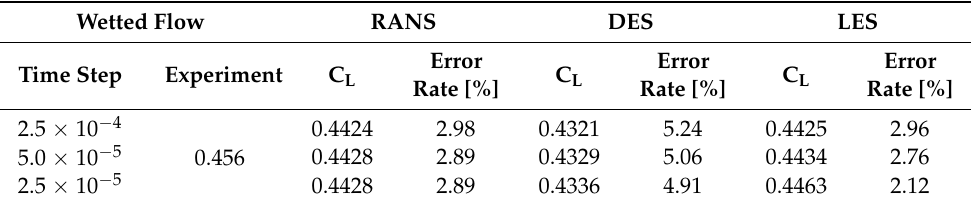
Table 2. Time-averaged lift coefficient at wetted flow according to the time steps and turbulence models (RANS, DES,